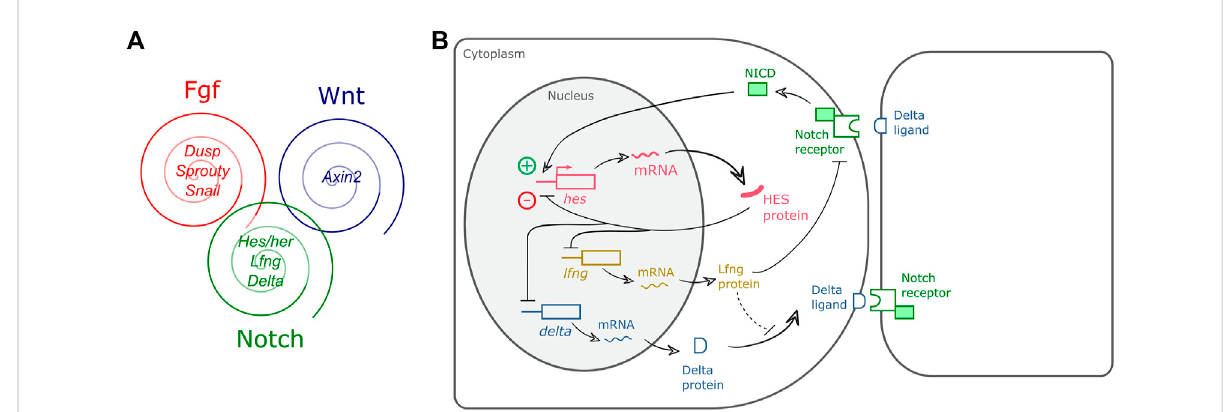
FIGURE 1 Embryo Clock (EC) gene expression oscillations. (A) The EC encompasses oscillatory genes belonging to the Fgf, Wnt and Notch signalling pathways (representative genes are indicated); (B) Negative feedback regulation of hairy-enhancer-of-split (HES) oscillations. In PSM cells, hes transcription is induced by pulses of intercellular Notch-Delta signalling, leading to HES protein production. HES protein enters the nucleus and repressesitsownpromoter.HESproteinandmRNA arerapidly degradedallowingfor anewcycleofexpression.HESalso inhibits delta and lfng expression ensuring coupled oscillations in neighbour cells of the tissue. Dashed line represents a delay imposed on Delta integration in the cell membrane (Yoshioka-Kobayashi et al., 2020). NICD: Notch intracellular